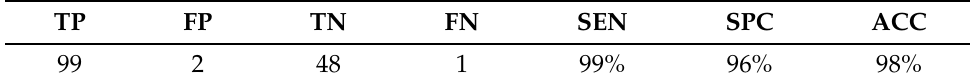
Table 1. Confusion matrix and